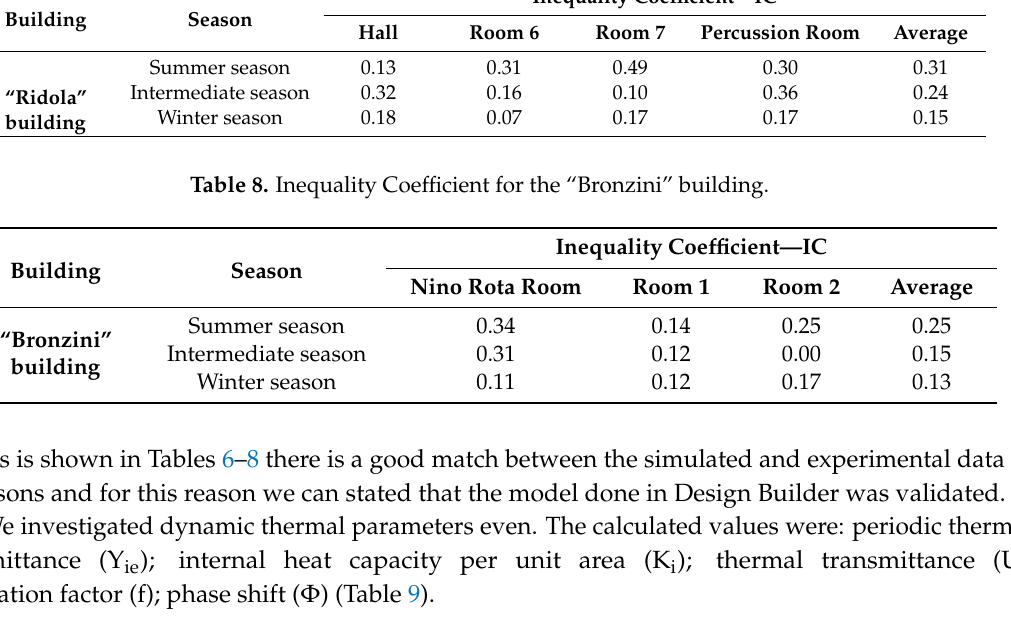
Table 9. Dynamic thermal